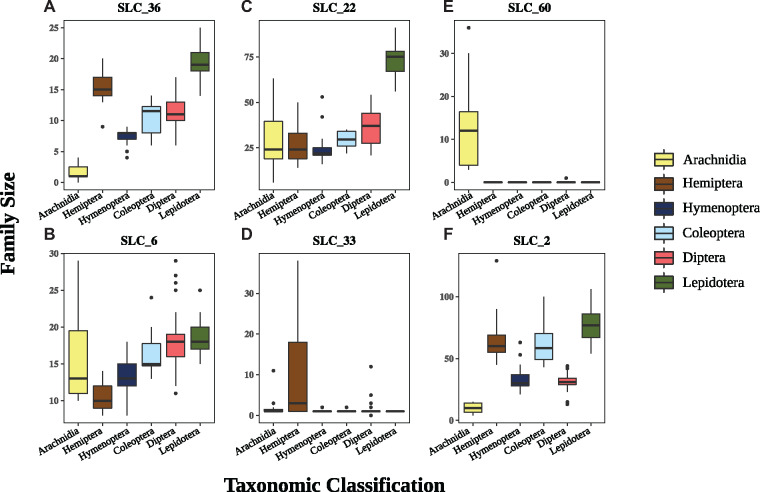
Variation in SLC family size among taxonomic groups. The x-axis of each boxplot shows the six different taxonomic groups represented by at least eight species in our data set. The y-axis shows the family size in a given family (A, SLC36; B, SLC22; C, SLC2; D, SLC6; E, SLC60; F, SLC33). The box of each plot is represented by quartiles 1 and 3, whereas the lines represent 1.5 times the quartile range. Outliers are represented by black dots.